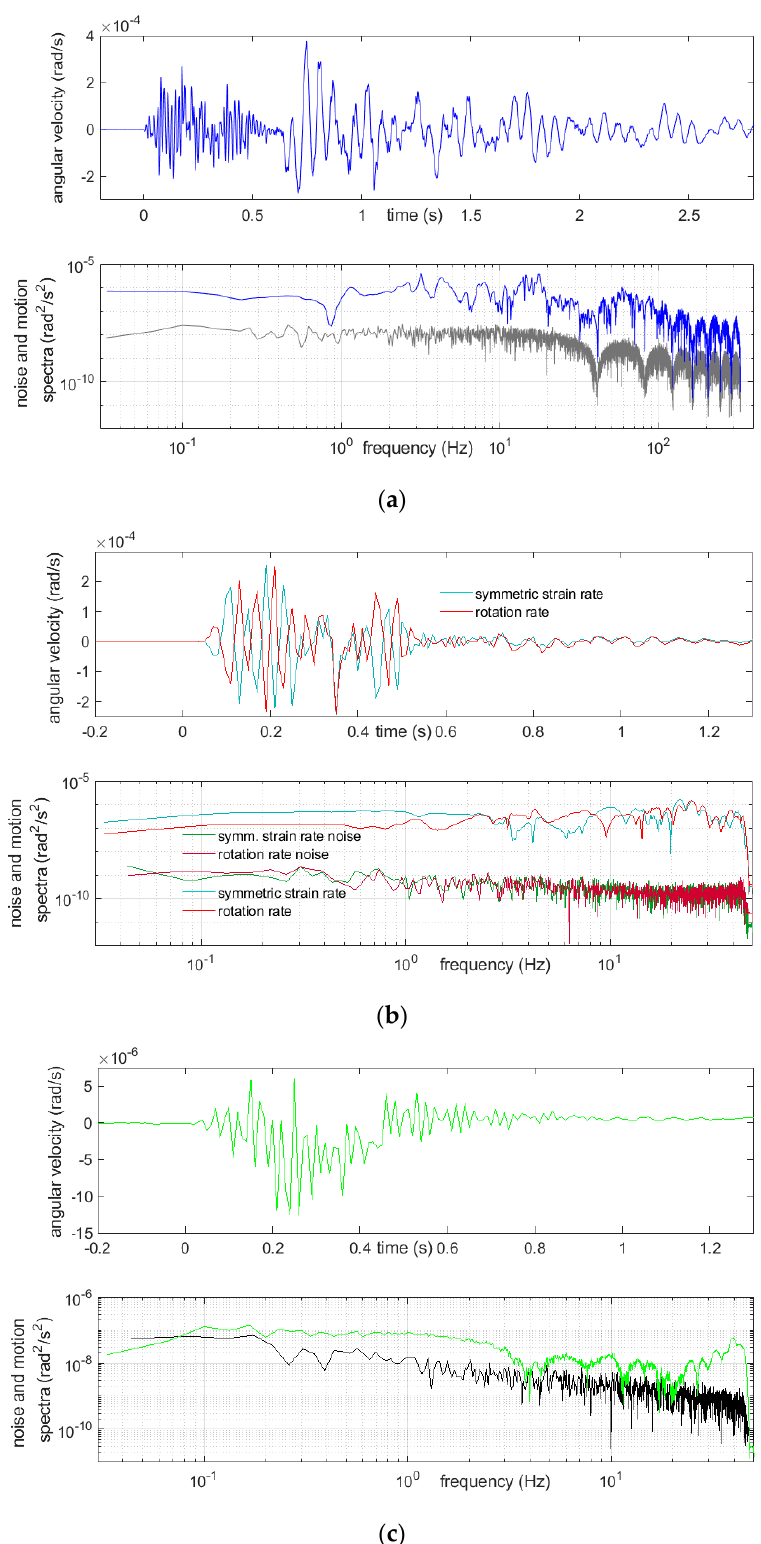
Figure 9. Recordings of the strongest multiple blast, No. 52, on April 30th of 30 charges in 15 time delays and a total mass of 12,750 g: ( a ) from FOSREM, the rotation rate and below its spectrum (blue), together with the rotational noise spectrum (gray), ( b ) from TAPSs, the symmetric strain rate (turquoise) and rotation rate (red) and below the spectra of these motions, together with adequate noise spectra and ( c ) from the CZ sensor, the rotation rate and below its noise (green), together with the rotational noise spectrum